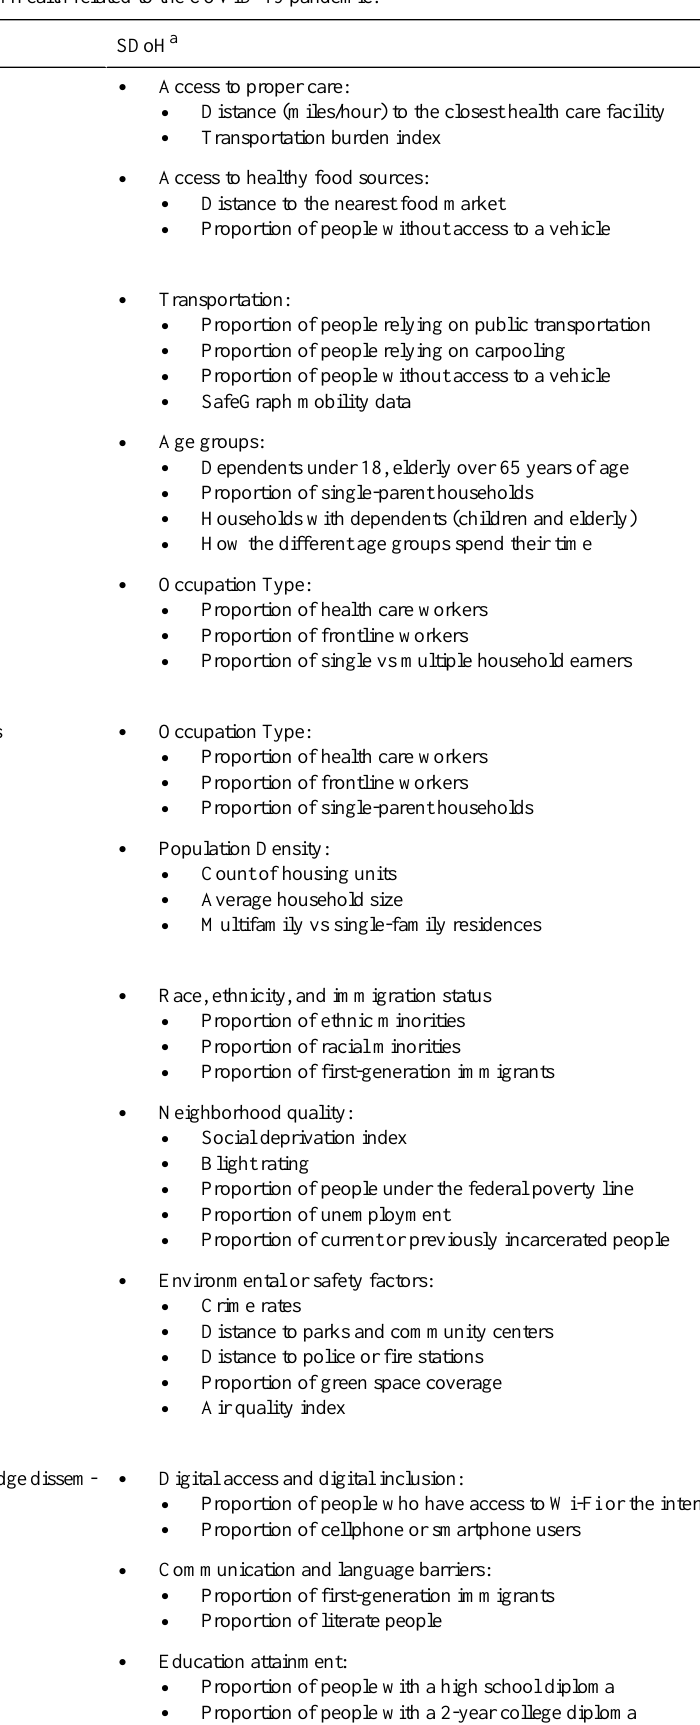
Table 1. Classification of Social Determinants of Health related to the COVID-19